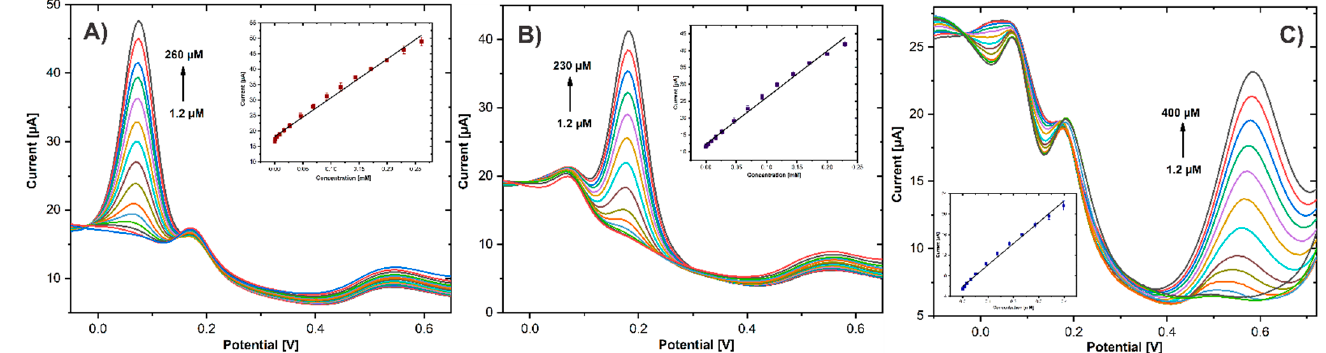
Figure 9. DPVs of GCE/ErGO-cMWCNT/AuNPs in 0.01 PBS (pH 7.0) containing ( A ) 25 μ M CC, 50 μ M RS, and different concentrations of HQ; ( B ) 25 μ M HQ, 50 μ M RS, and different concentrations of CC; ( C ) 25 μ M HQ, 25 μ M CC, and different concentrations of RS. Inset plots of the peak current as a function HQ, CC, and RS concentrations.